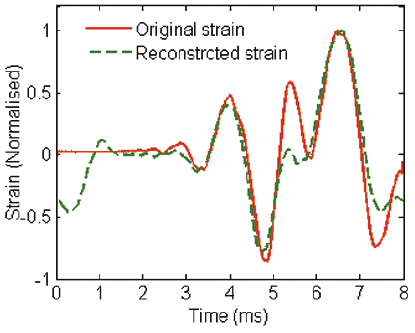
Fig. 6. Shapes of strain by sensor 3 in impact #3 compared with the original strain